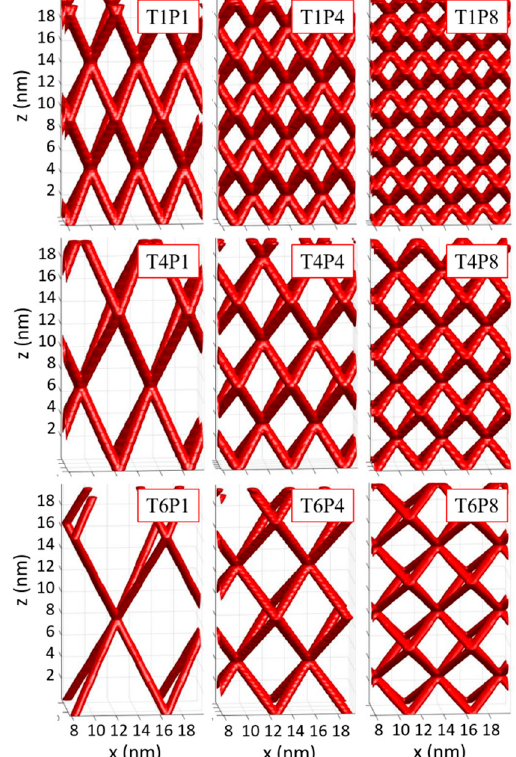
Figure 4. Simulated selected networks of the nanowires obtained from different deposition conditions. The simulations were performed using the parameters obtained from the GISAXS analysis. It was assumed that the structure was ideal with no disorder.